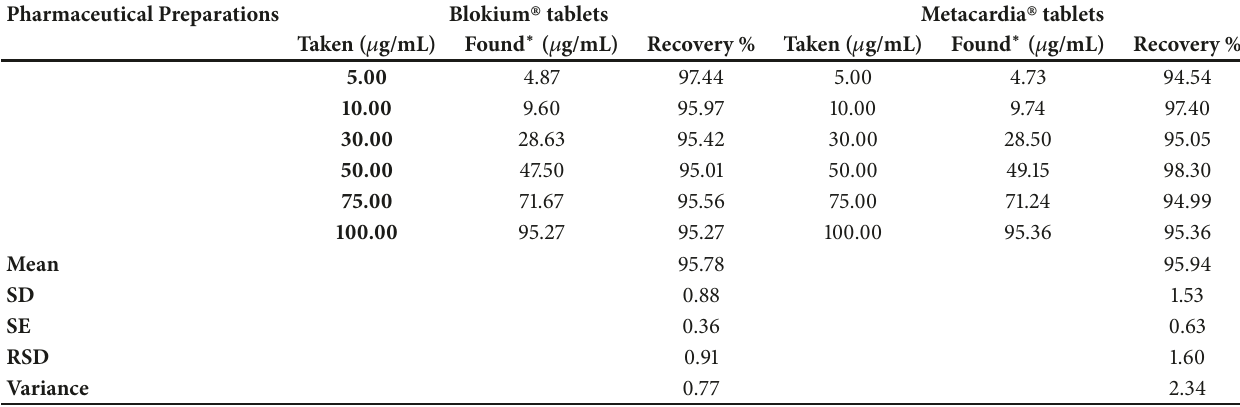
Table 6: Application of the proposed method in standard solution on pharmaceutical tablets. Pharmaceutical